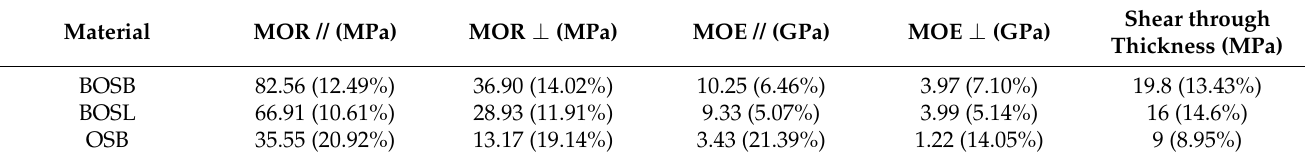
Table 1. Mechanical properties of individual materials.